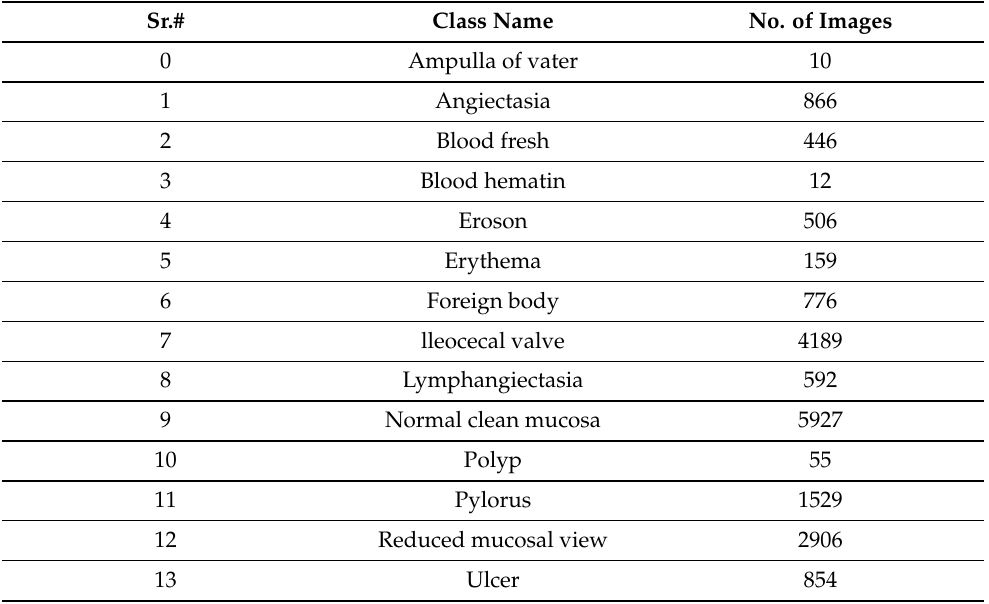
Table 2. Distribution of image samples in WCE dataset before up-sampling.